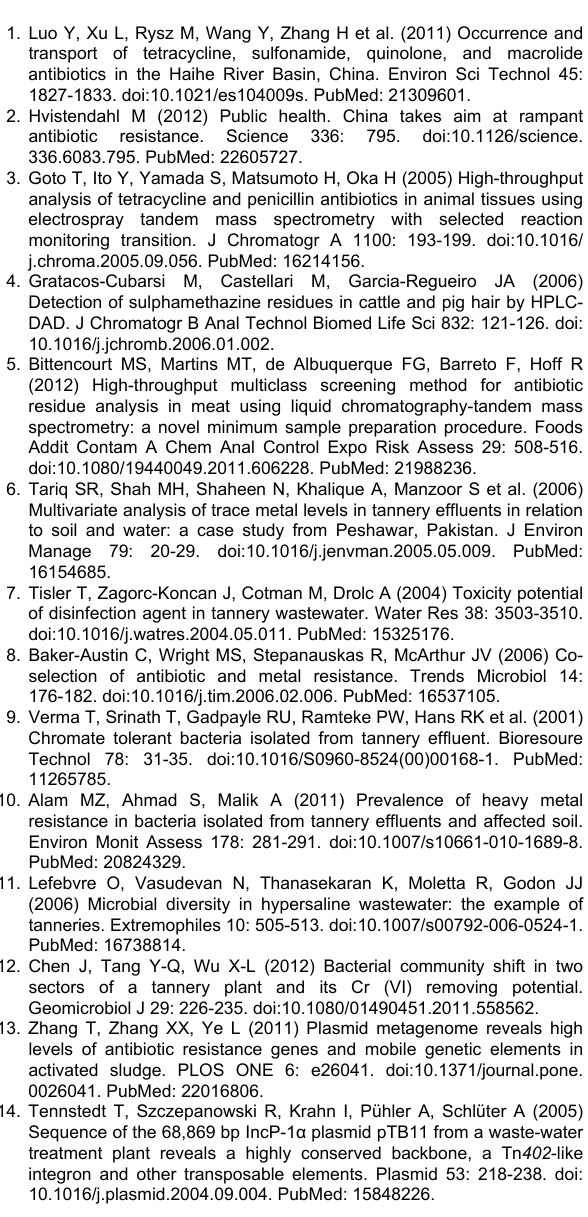
Table S6. Matched high-throughput sequencing reads of integron integrase genes in anaerobic and aerobic sludge against the INTEGRALL database. (Ranked by reads number of the identified integron integrase genes in aerobic sludge).